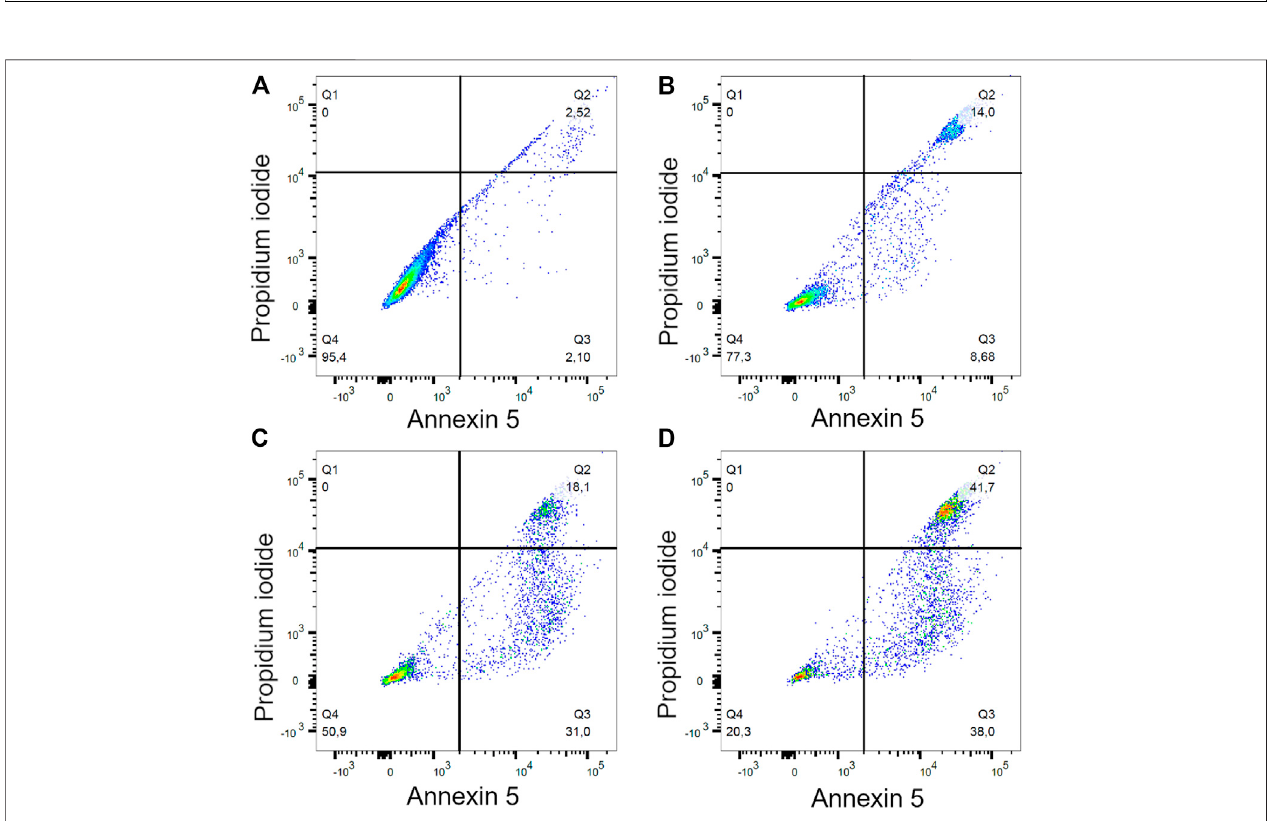
Frontiers in Pharmacology |